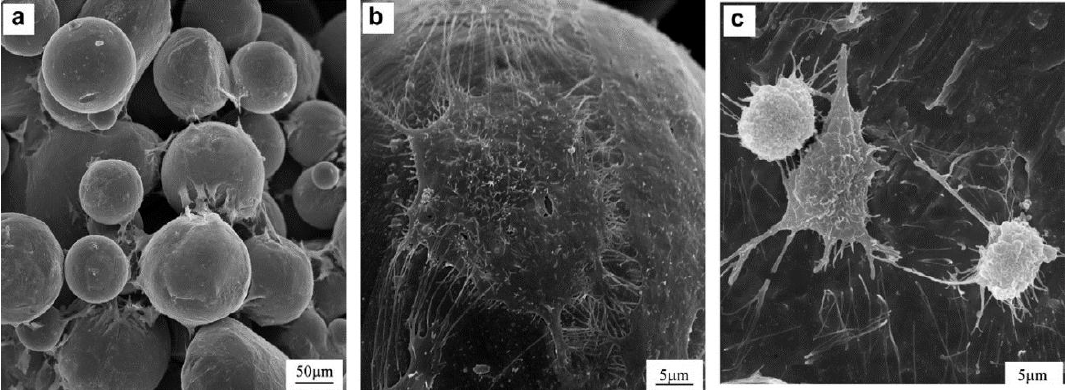
Figure 9. SEM micrographs of OPC1 cells after 3 days of culture on: ( a , b ) porous Ti (27% porosity), showing flattened and well-spread morphology; ( c ) Ti plate, showing more rounded shape [47].